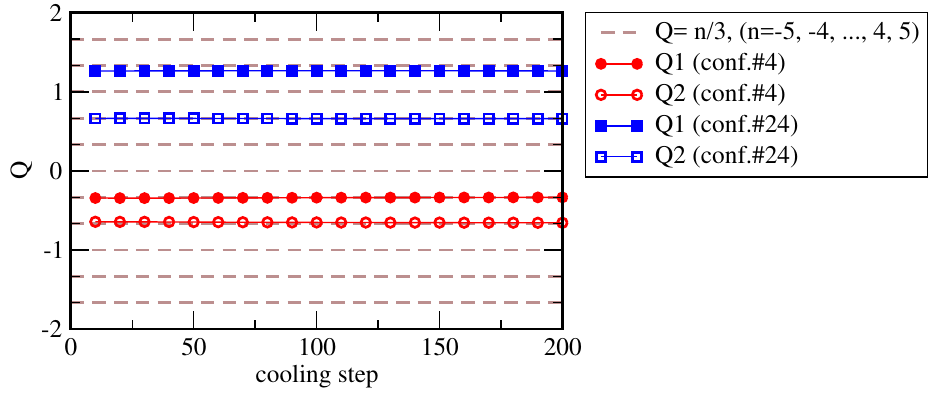
Figure 5 . Cooling step dependence of the local charges, Q 1 ((cid:12)lled symbol) and Q 2 (open symbol), for confs. #4 (red-circle) and #24